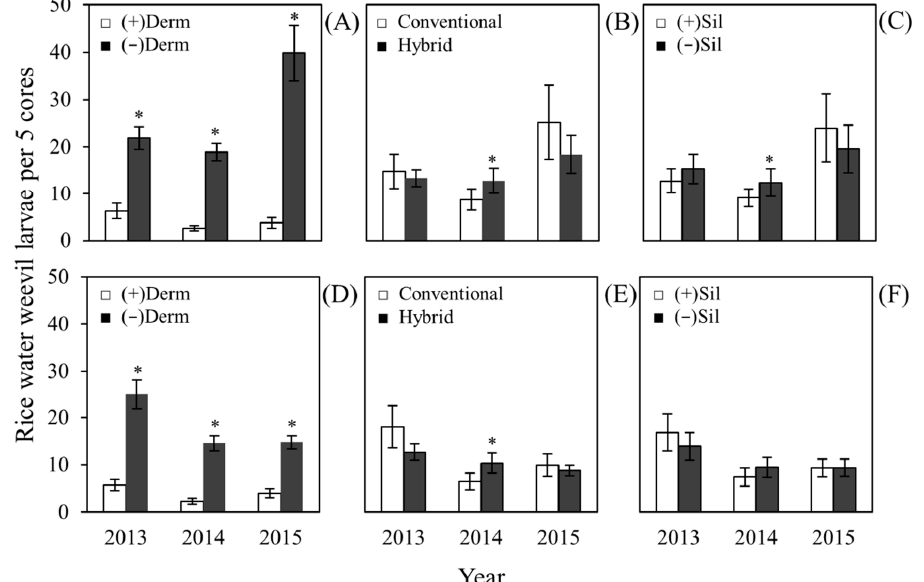
Figure 2. Main effects of Dermacor seed treatment, variety, and silicon amendment on rice water weevil larval densities. Core 1 ( A , B, and C ) and Core 2 ( D , E, and F ) sampling were performed three and four weeks after permanent flooding. ( A and D ), main effect of Dermacor treatment; ( B and E ), main effect of variety; ( C and F ), main effect of silicon amendment in 2013, 2014, and 2015. For each year, bars accompanied by asterisks designate significant differences ( P < 0.05; Tukey’s HSD). The bars represent standard error of means (SEM). Table 1. Statistical comparisons of the effects of variety (Var), Dermacor seed treatment (Derm), silicon amendment (Sil), and their interactions on rice water weevil larval densities. Core 1 and Core 2 sampling were performed three and four weeks after permanent flooding in 2013, 2014, and 2015. Treatment Larval Density Treatment